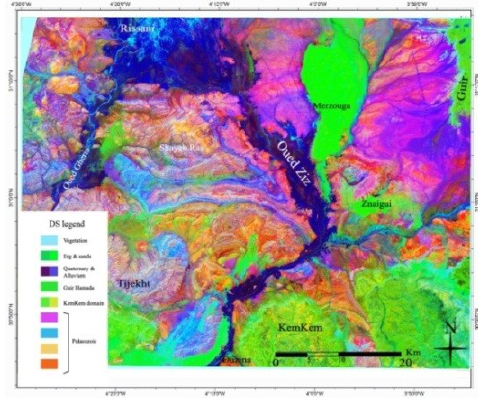
Figure 8: (b) Decorrelation stretch for the best OIF combination (R=b8, G=b11, B=b2).